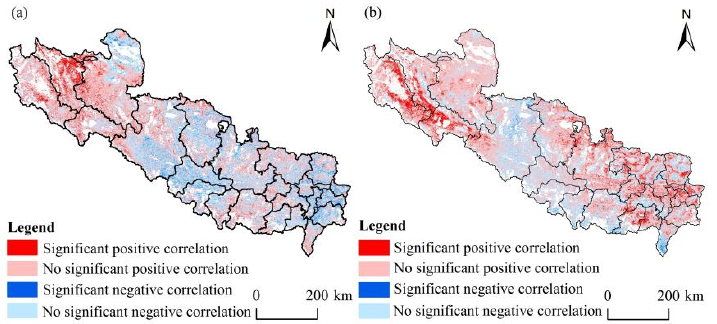
Figure 6. Correlation between NDVI and annual mean temperature ( a ) and precipitation ( b ) in the growing season of the SWTP from 2000 to 2020.